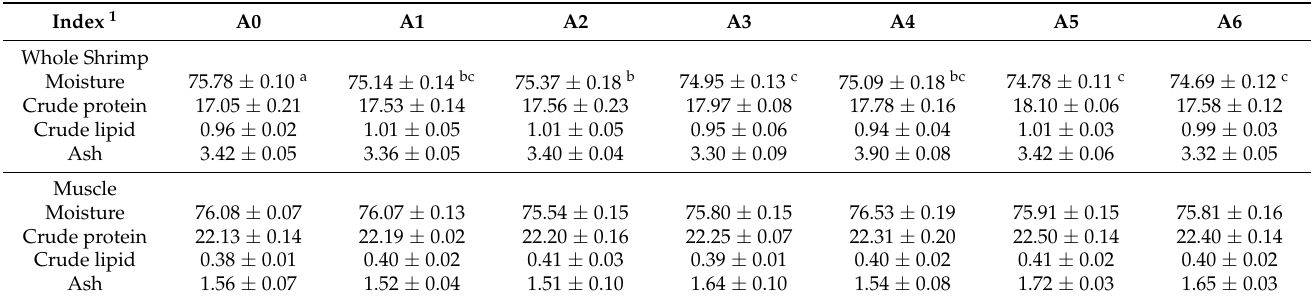
Table 3. Effects of Yarrowia lipolytica on the whole shrimp and muscle composition of Litopenaeus vannamei (%) 1 .